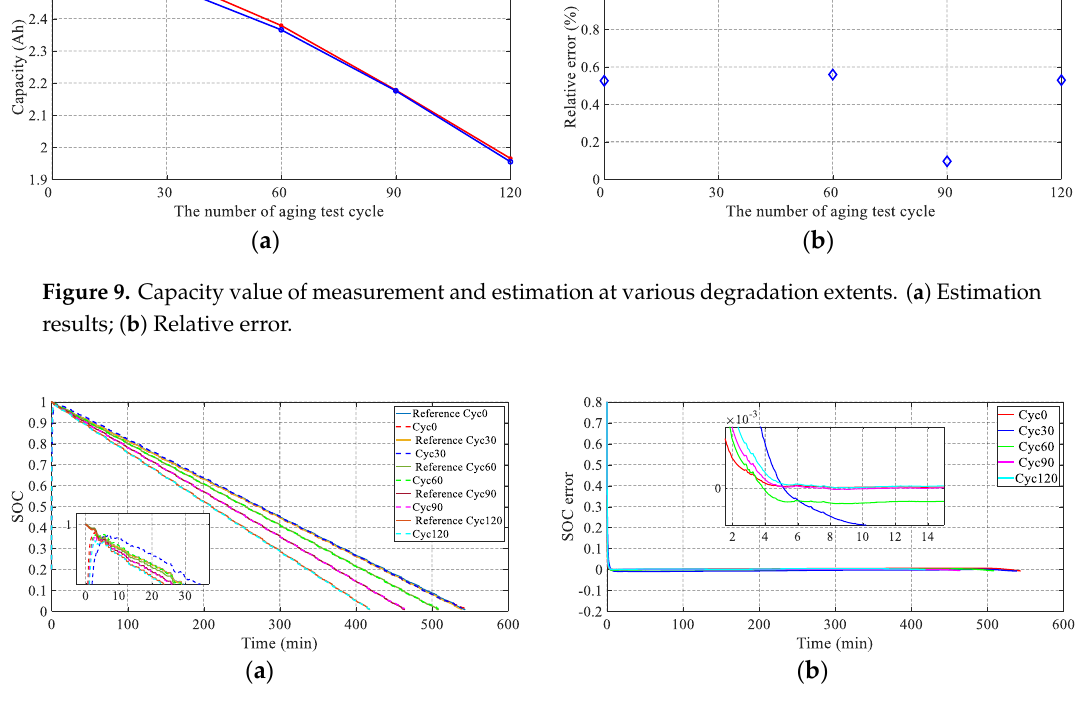
Figure 10. The results of SOC estimation with the aged battery cell: ( a ) SOC estimation results; ( b ) SOC error.